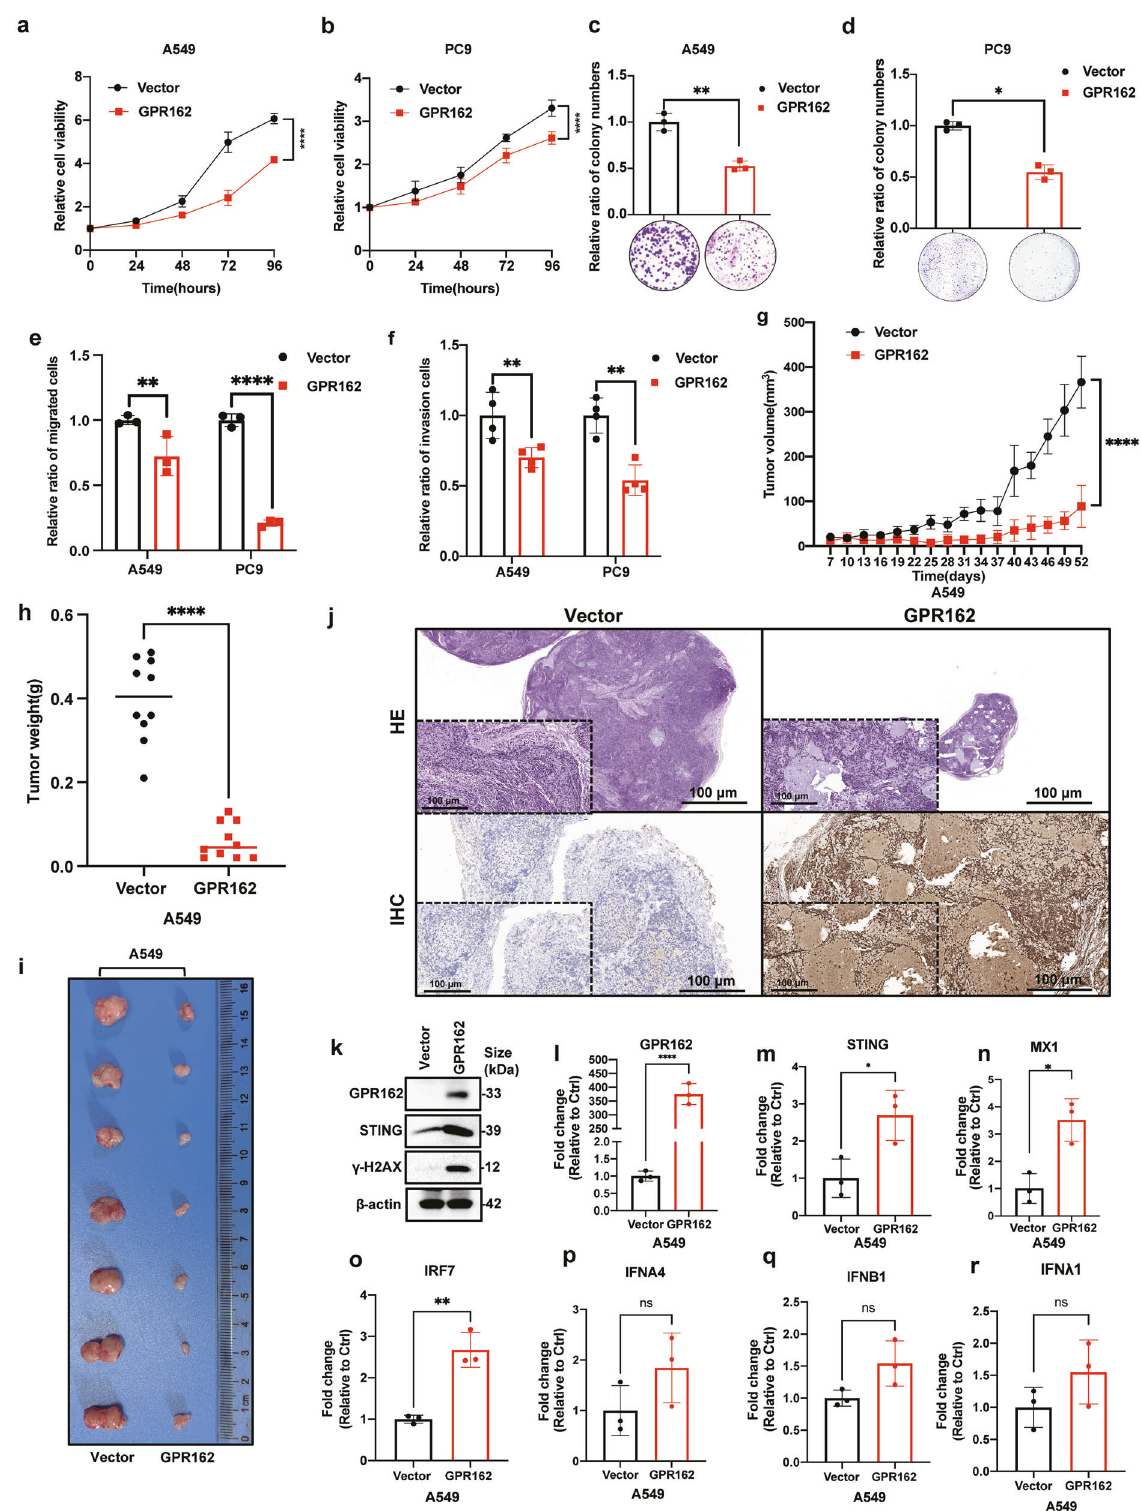
Fig. 6 GPR162 overexpression slowed cell proliferation, colony formation, transwell migration and invasion, and tumor development. a , b Cell viability was determined using the CCK8 assay in A549 ( a ) and PC9 ( b ) cells that were stably overexpressing GPR162. c , d A colony formation experiment on plates was used to assess the ability of A549 ( c ) and PC9 ( d ) cells overexpressing GPR162 to form colonies. e , f The migration and invasion of A549 and PC9 cells overexpressing GPR162 were detected using a transwell test. g , i To investigate the capacity of A549 cells with stable GPR162 overexpression to develop tumors ( n = 10 mice per group), a tumor growth xenograft model was established. Tumor formation was tracked at the indicated times ( g ), weight ( h ), and image ( i ). j The tumor tissue of the xenograft model was evaluated by HE and IHC. k GPR162, STING, and γ H2AX expression levels in tumor tissue were determined by western blot analysis. l – r qPCR analyses of GPR162 ( l ), STING ( m ), MX1 ( n ), IRF7 ( o ), IFNA4 ( p ), IFNB1 ( q ), and IFN λ 1 ( r ) in tumor tissue. (* p < 0.05, ** p < 0.01, **** p < 0.0001) Signal Transduction and Targeted Therapy (2023)